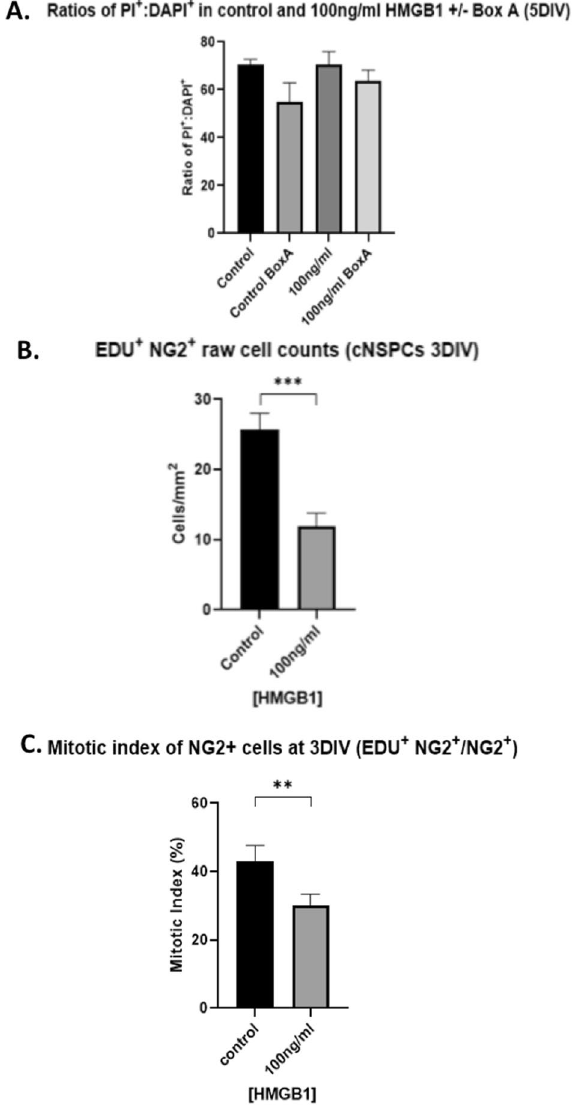
Figure 4. Disulfide HMGB1 inhibits oligodendrocyte progenitor cells proliferation with no effect on the overall survival. ( A ) Cell death was not significantly influenced by the presence of disulfide HMGB1. The addition of BoxA to cultures did not impact upon the proportion of PI + (dead) cells. Therefore, HMGB1, nor TLR4/2 blockade, affected overall cell death in these cell cultures. ( B ) NG2 + cell counts were significantly reduced in the presence of 100 ng/ml disulfide HMGB1 verses control cultures. ( C ) Disulfide HMGB1 at 100 ng/ml significantly reduced the mitotic index for NG2 + cells. For comparisons between two conditions, two-tailed student’s T-test was used, and for multiple different conditions, a two ‐ way ANOVA and one-way ANOVA with Dunnett’s multiple comparison test was used. p values of < 0.05 were considered significant (* p < 0.05; ** p < 0.01; *** p < 0.001; **** p < 0.0001). cNSPCs = rat cortical neural stem cell progenitors; DIV = days in